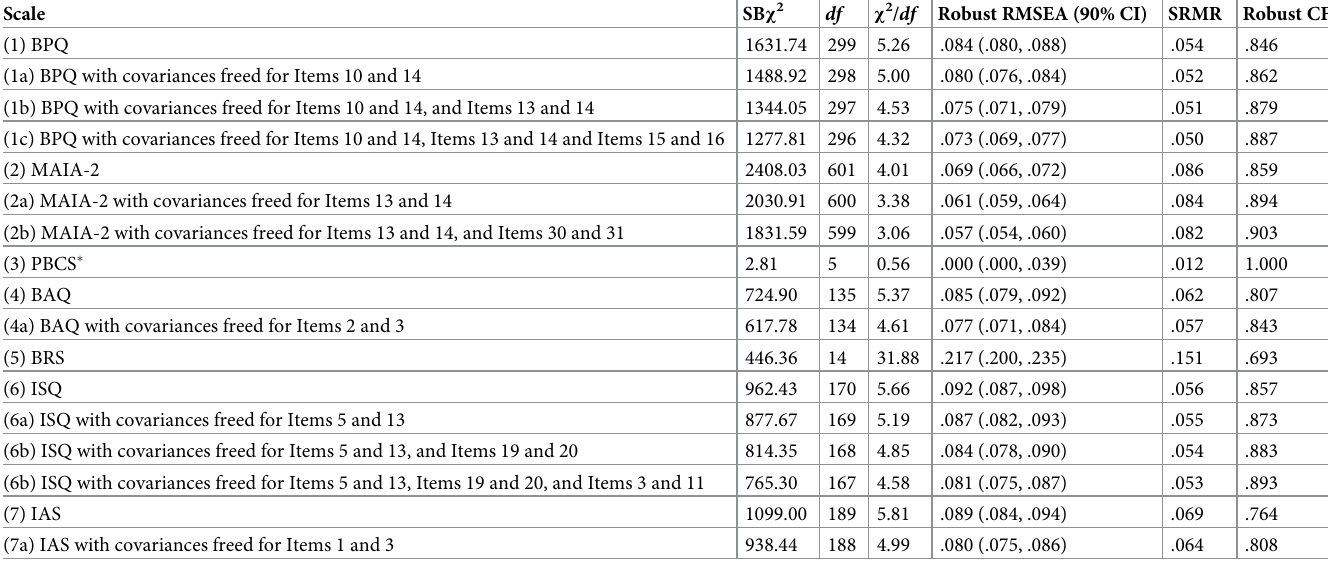
Table 1. Results of confirmatory factor analyses examining fit of the parent models for each of the scales included in the present study. Scale